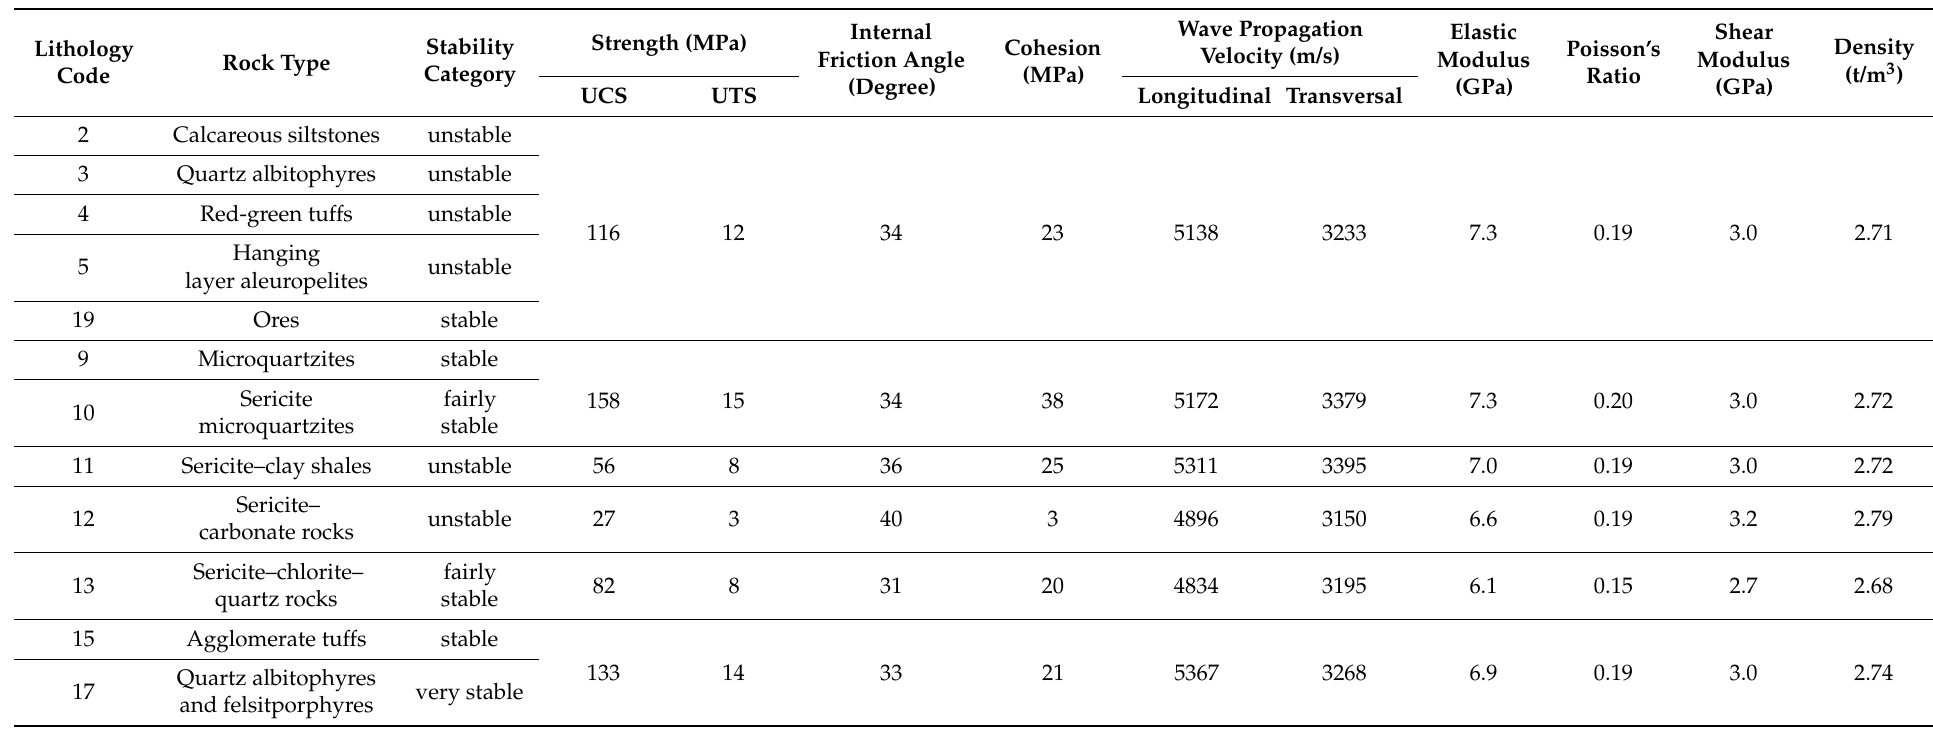
Table 1. Generalized physico-mechanical properties of rock domains of Ridder–Sokolny